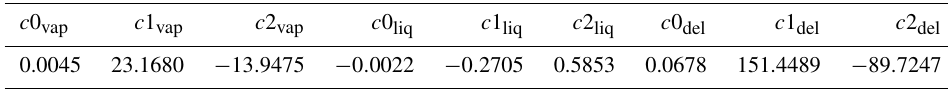
Table 3. Structure of the grid file “we_iconeu_4deg.grd”. Column: 1 2 3 4 ... 63 Grid point 1 Latitude ( ◦ ) Longitude ( ◦ ) Surface